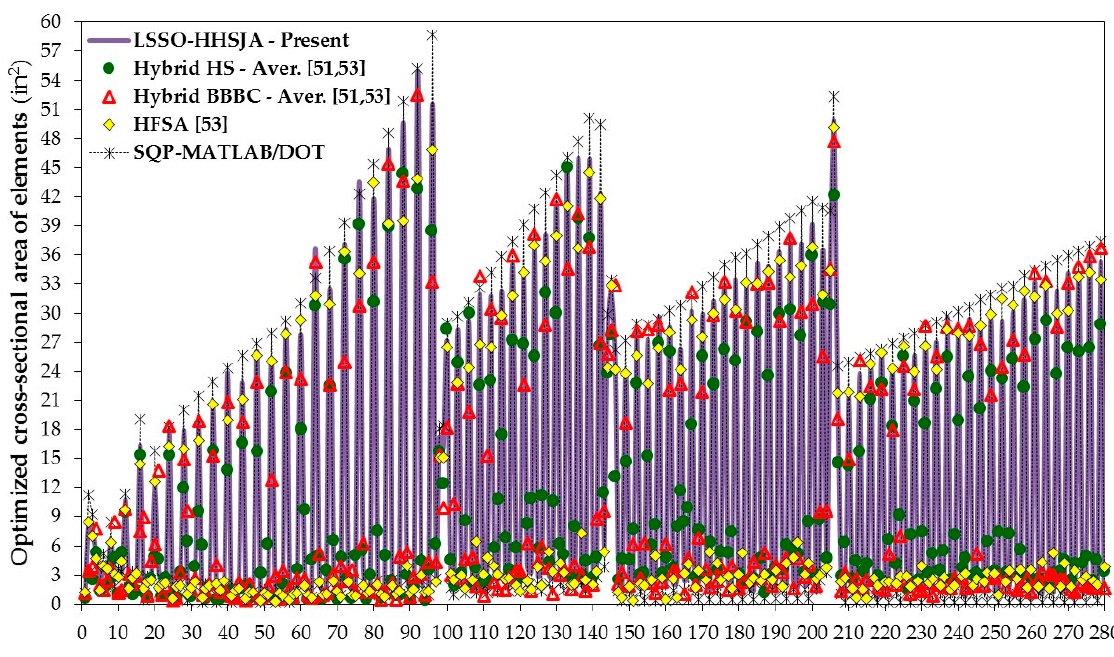
Figure 7. Optimized cross-sectional areas of the 3586-bar tower.